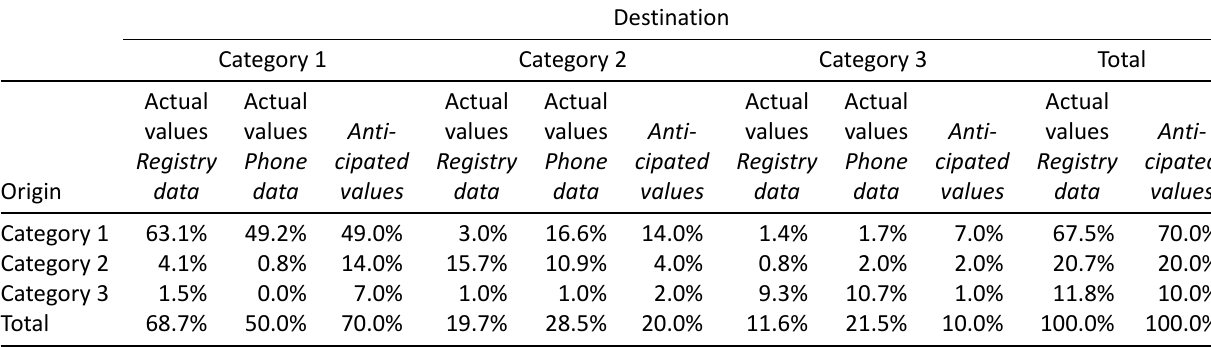
Table 2. Flows across area categories (Falun-Borlänge).